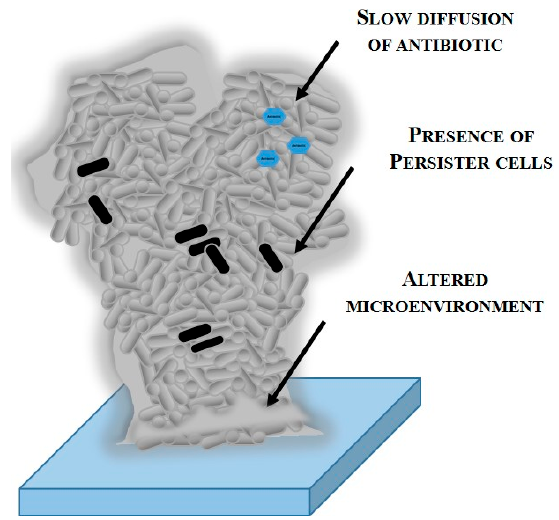
Figure 2. Main mechanisms of biofilm resistance to antibiotics.